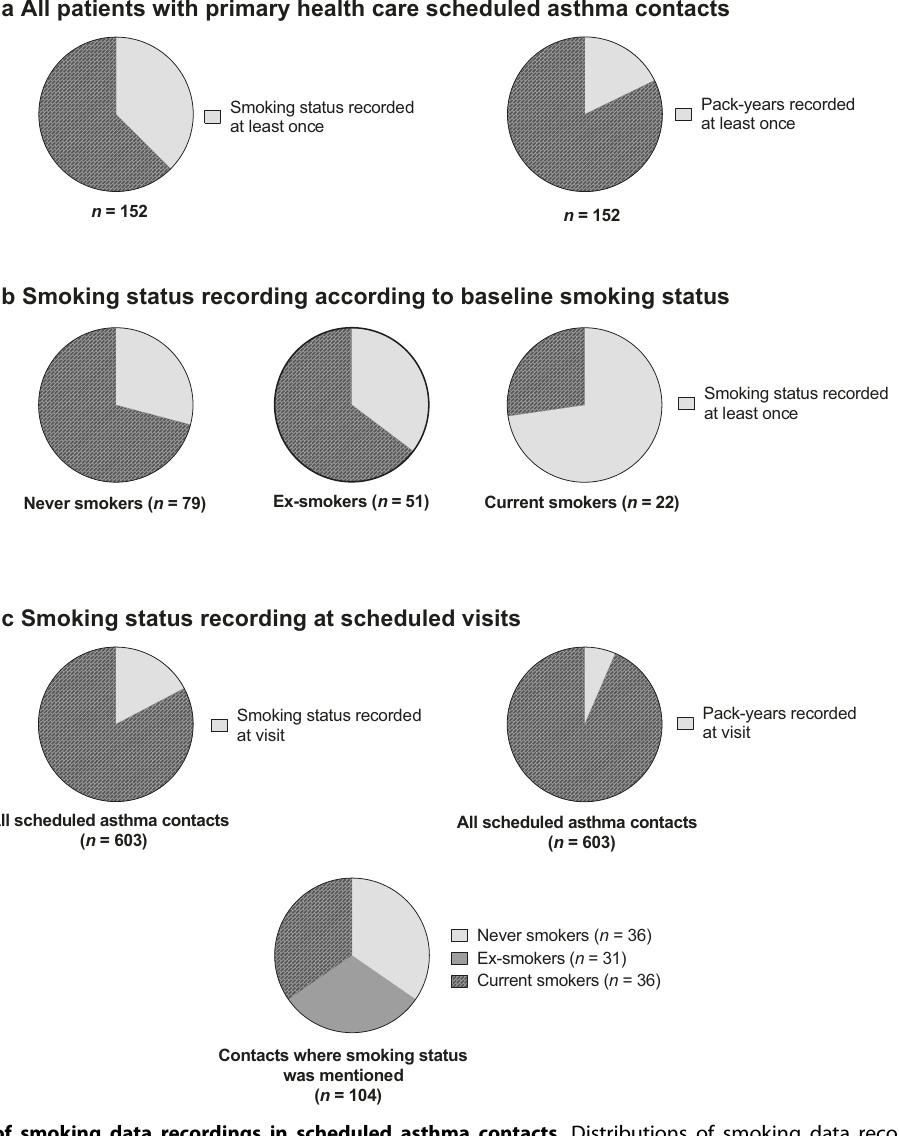
Fig. 3 Distributions of smoking data recordings in scheduled asthma contacts. Distributions of smoking data recordings according to a study population, b baseline smoking status, and c number of scheduled